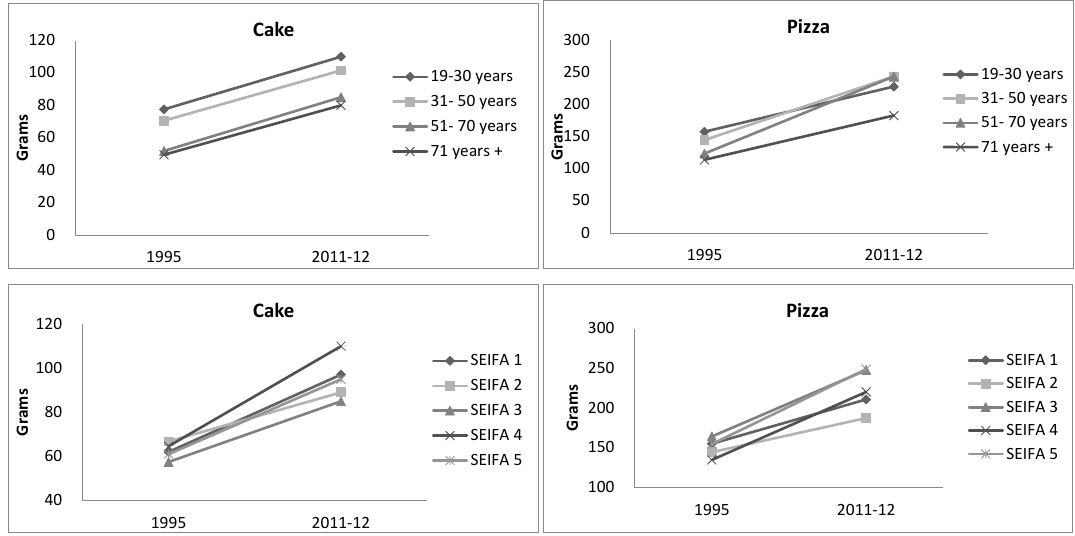
Figure 2. Percentage difference in median portion size (in grams) between 1995 and 2011–2012 by gender. * p < 0.05.